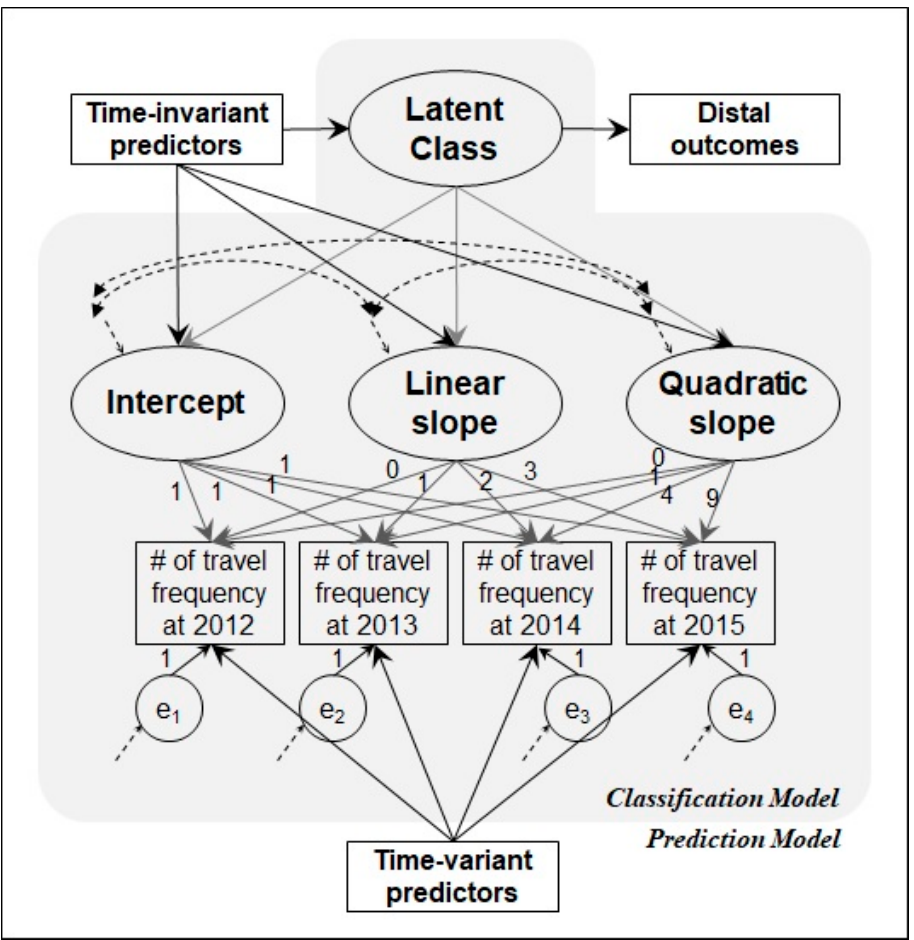
Figure 1. A graphical representation for GMM research. Note(s) : Covariance and variance paths are depicted in dotted lines. The numbers on the one-arrow lines are fixed path coefficients.